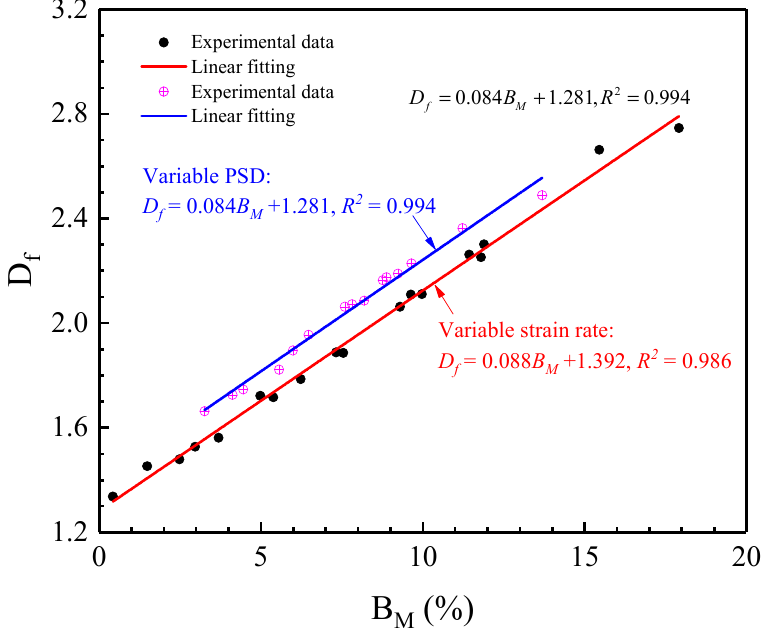
Figure 20. Relationship between breakage ratio and fractal dimension following fragmentation. Breakage ratio B M indicates change in PSD of original rock particles. Blue curve arises from samples having different initial PSDs; red curve is from different strain rates being applied.